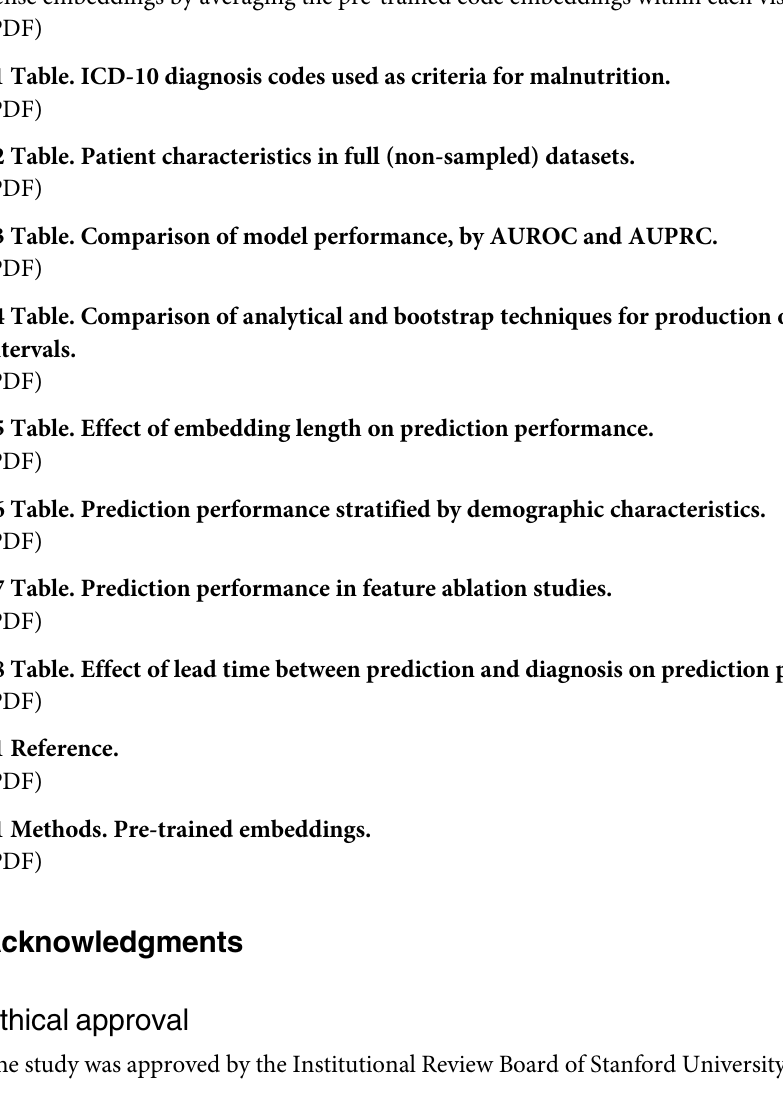
S2 Fig. One-hot encoding representation of visits. Patient trajectories are pre-processed into one-hot (binary) encoded representations. S3 Fig. Diagnosis and procedure code embeddings. Pre-trained embeddings are created by training a two-layer fully connected network using a dataset created from target-context pairs of diagnostic and procedural codes from each visit. S4 Fig. Dense embedding representation of visits. Patient trajectories are transformed into dense embeddings by averaging the pre-trained code embeddings within each visit. S1 Table. ICD-10 diagnosis codes used as criteria for malnutrition. S2 Table. Patient characteristics in full (non-sampled) datasets. S3 Table. Comparison of model performance, by AUROC and AUPRC. S4 Table. Comparison of analytical and bootstrap techniques for production of confidence intervals. S5 Table. Effect of embedding length on prediction performance. (PDF) S6 Table. Prediction performance stratified by demographic characteristics. (PDF) S7 Table. Prediction performance in feature ablation studies. (PDF) S8 Table. Effect of lead time between prediction and diagnosis on prediction performance. (PDF) S1 Reference. (PDF)